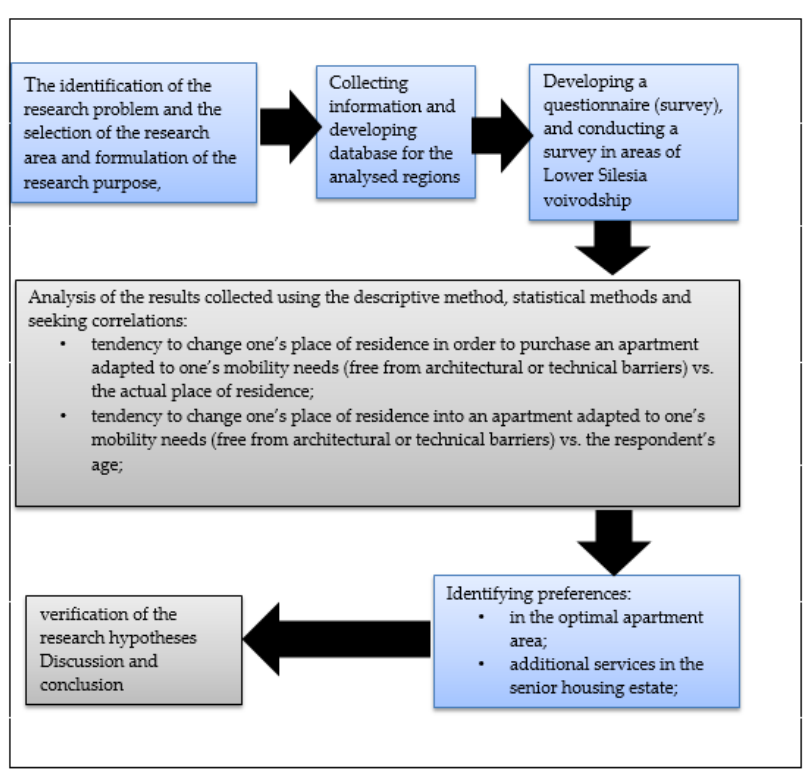
Figure 1. The research stages.